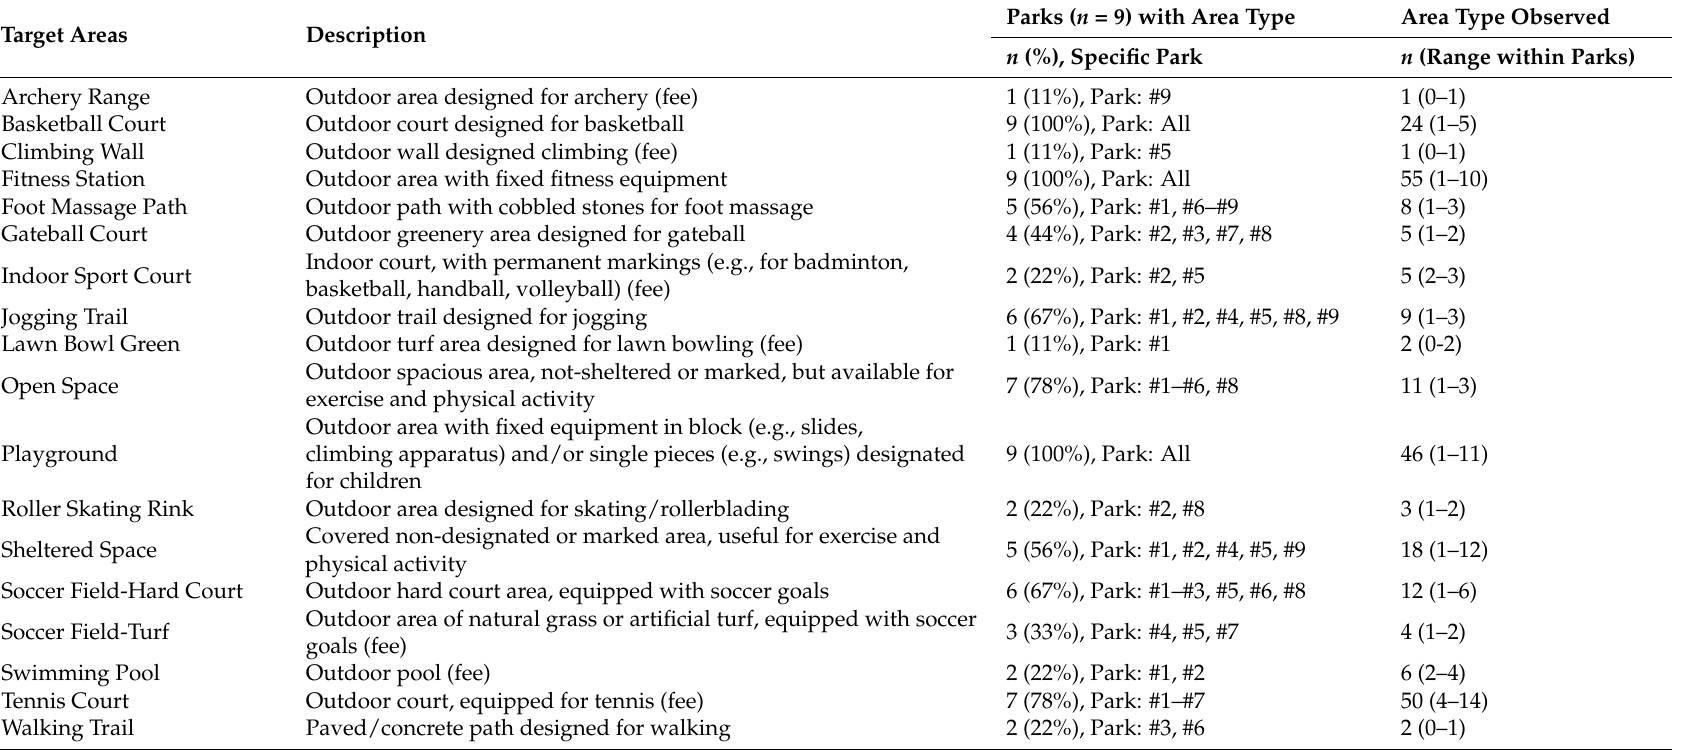
Table 2. Target areas observed (total n = 262) and number (proportion) of parks containing each